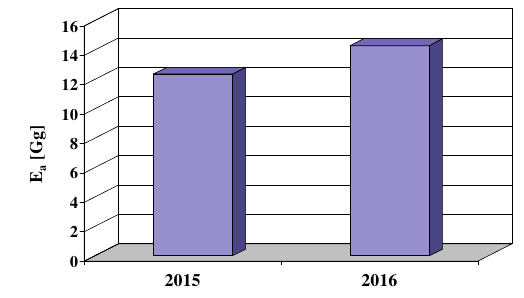
Fig. 4. National annual emission of carbon monoxide from motor vehicles in 2015 and 2016